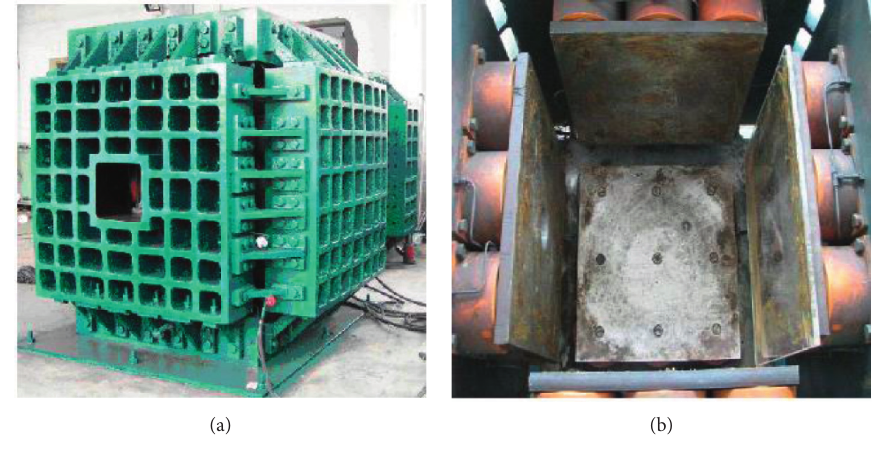
Figure 9: Comprehensive simulation testbed.